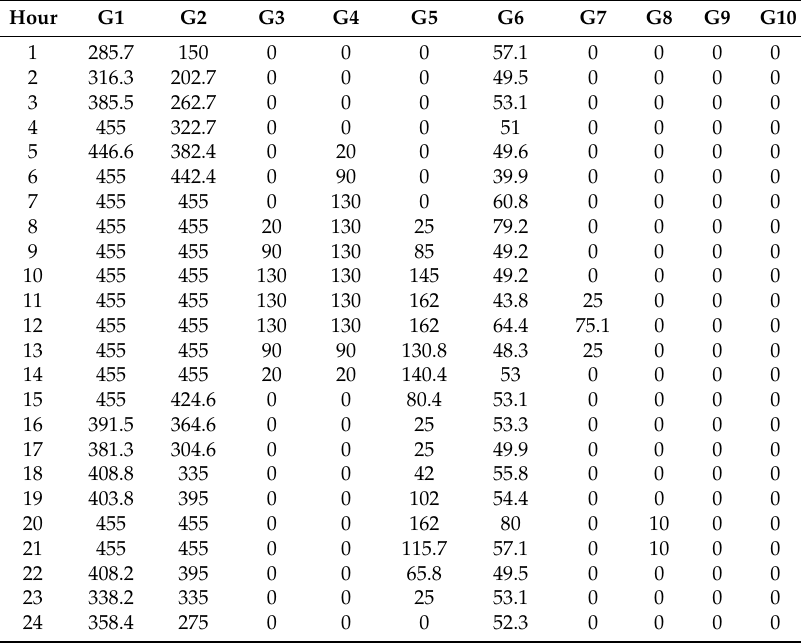
Table 1. Conventional units output (Case